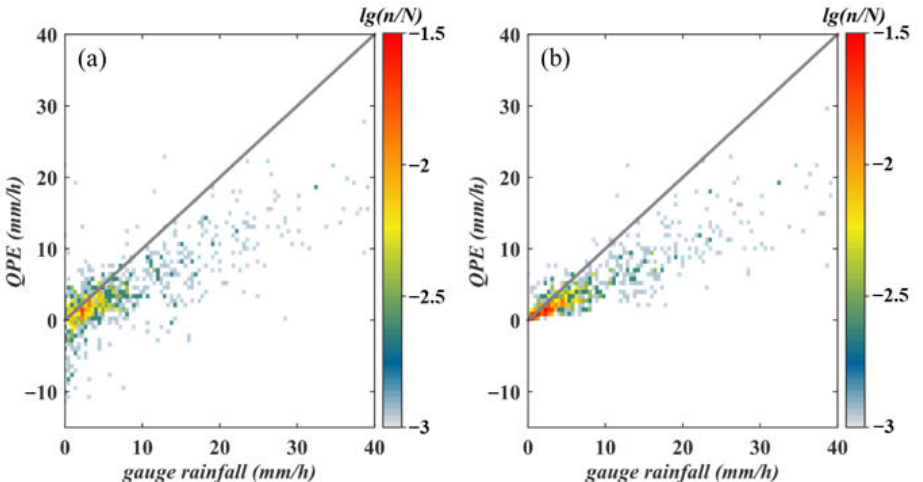
Figure 10. Colored density plot of 1 h rainfall by rain gauges vs. ( a ) QPE by EXP1 K DP (LS without δ -elimination) and ( b ) QPE by EXP4 K DP (LP with δ